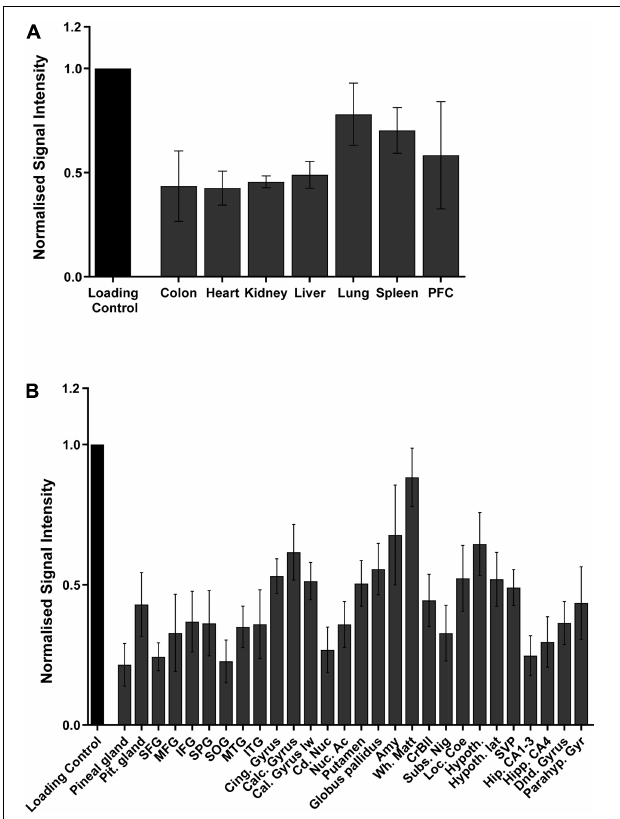
FIGURE 4 | Quantification of the distribution of 6mA throughout the different tissues in (A) mice and in (B) different human brain regions, via dot blot. Data are from four biological replicates in mice and five in humans, and presented as mean ± SEM.